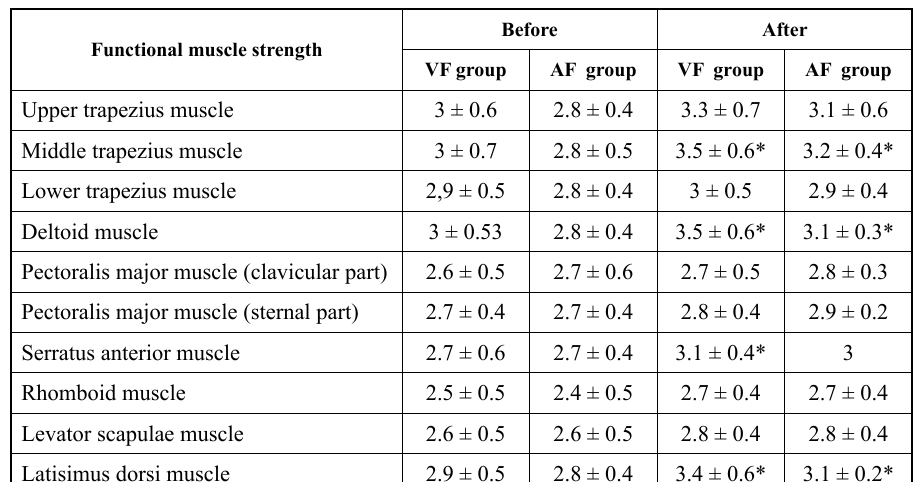
Note. All values are av - erages of every group subjects. Results are mea - sured on 1–5 Lovett scale. * p < .05, difference between pre-experimental and post- experimental results; # p < .05, difference between VF and AF group results.